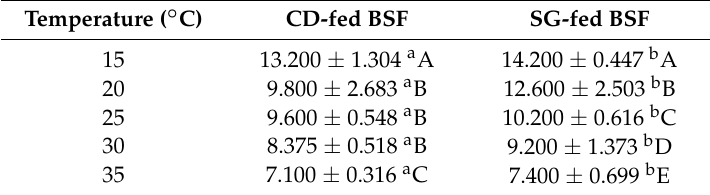
Table 4. Mean ( ± SD) longevity (in days) of adult black soldier fly reared on two different organic substrates at five different temperature